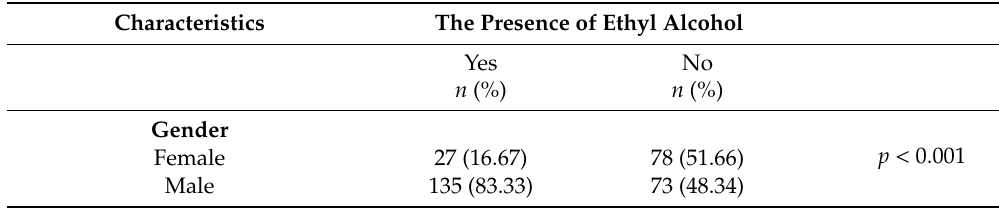
Table 2. Analysis of the relationship between the presence of alcohol in fatalities and gender, age, place of event, mechanism of the event, type of injury, and the place of